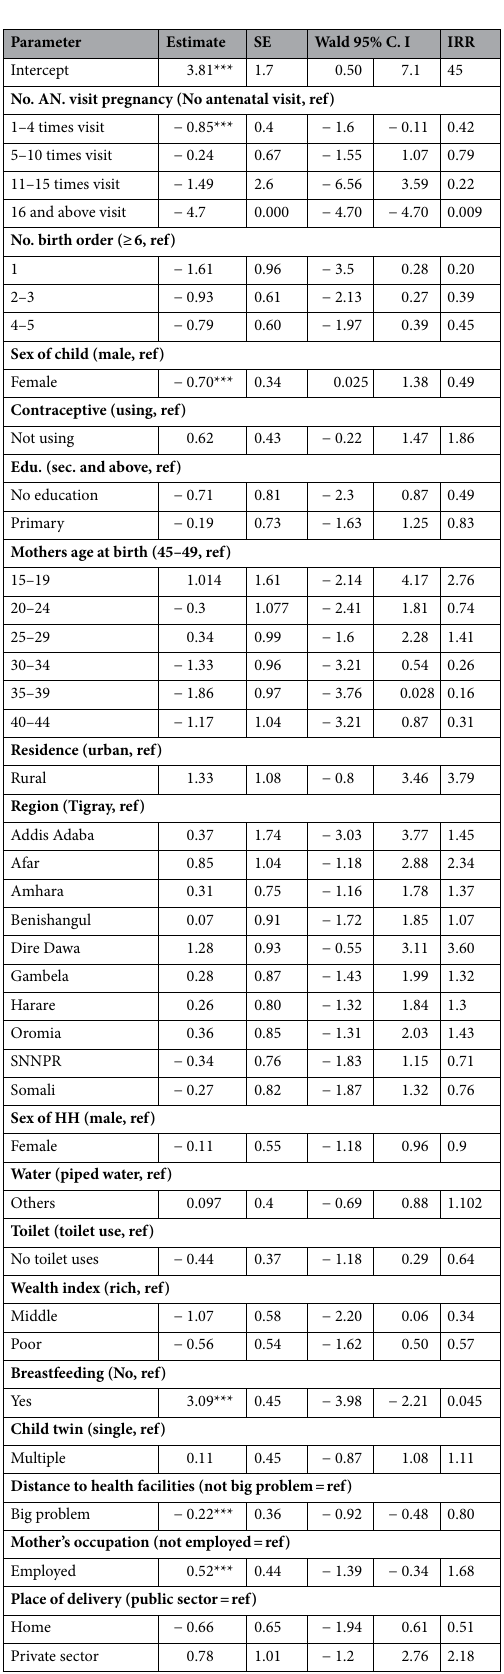
Table 8. Zero inflation parameter